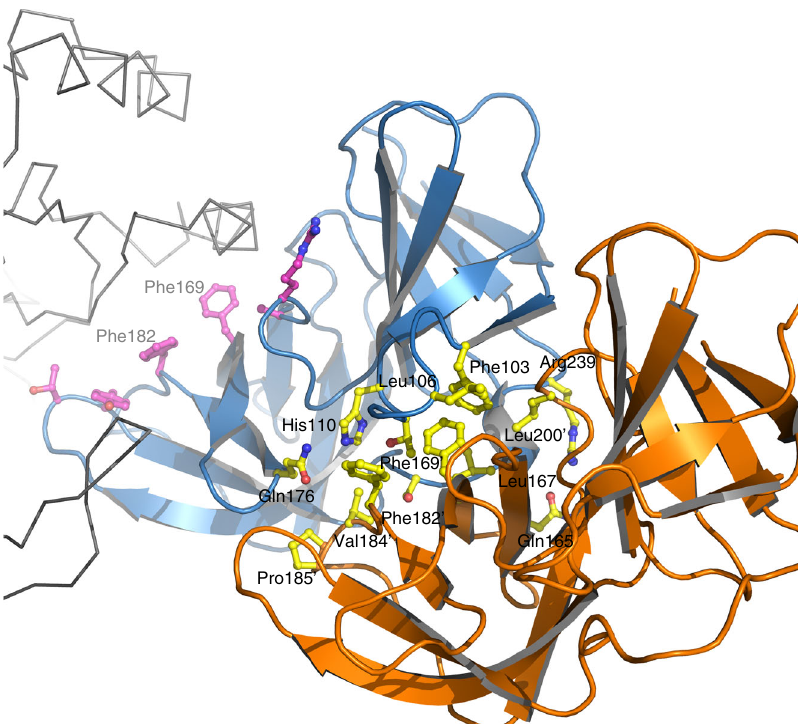
Fig. 5 MreC employs different surfaces in order to maximize interactions with partner molecules. MreC ( blue ) interacts both with PBP2 ( gray ribbon ) and with another MreC butter fl y ( orange ). The latter recognition region is composed mostly of hydrophobic interactions, with few exceptions ( yellow sticks ). Residues Phe169 and Phe182, localized at the center of the MreC – MreC interaction platform that is provided by a neighboring molecule (with apostrophes ), are also involved in the formation of the hydrophobic zipper that interacts with PBP2 ( purple sticks ). This suggests that MreC can modify the protein partner with which it interacts through a slight adjustment of the residues available for